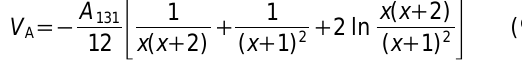
optimal dispersible point for Al 19% and f